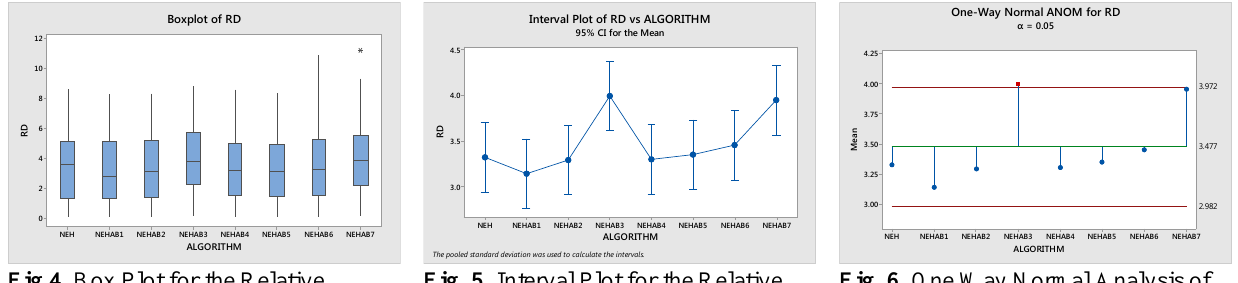
Fig. 5. Interval Plot for the Relative Deviations